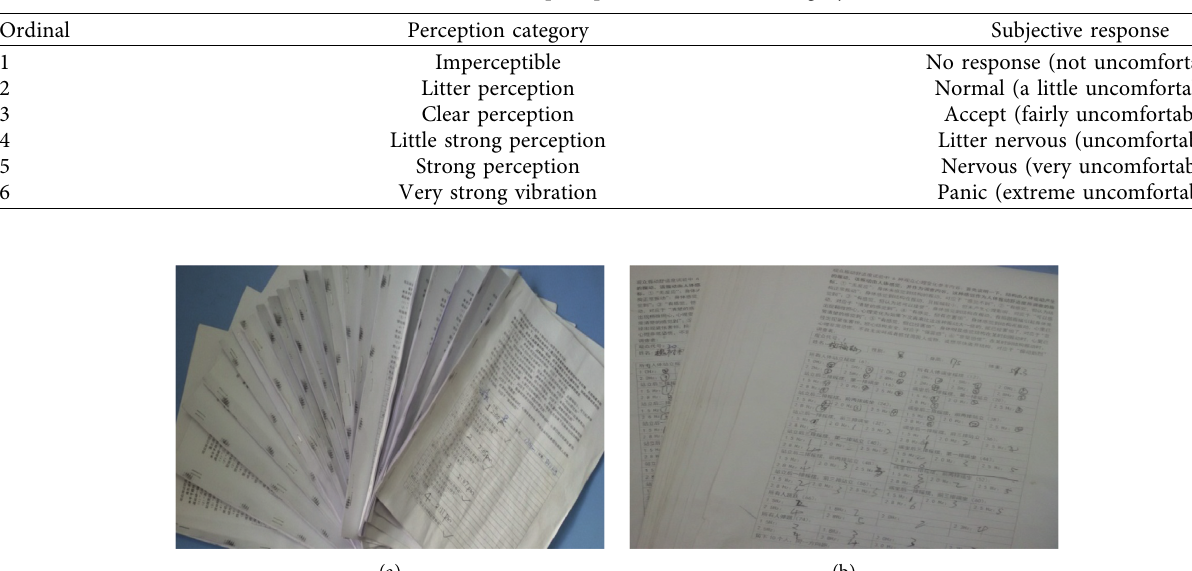
Figure 3: The test structure. (a) The test points of accelerometer and displacement; (b) test instruments. Table 3: Human perception and comfort category.